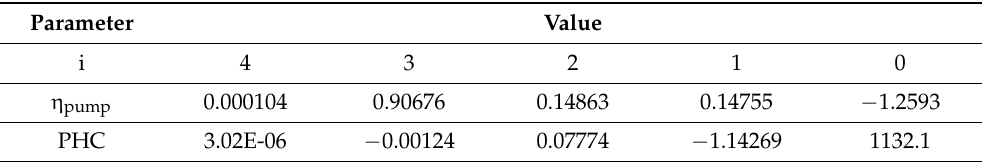
Table 2. Polynomial coefficients for describing pump characteristics.